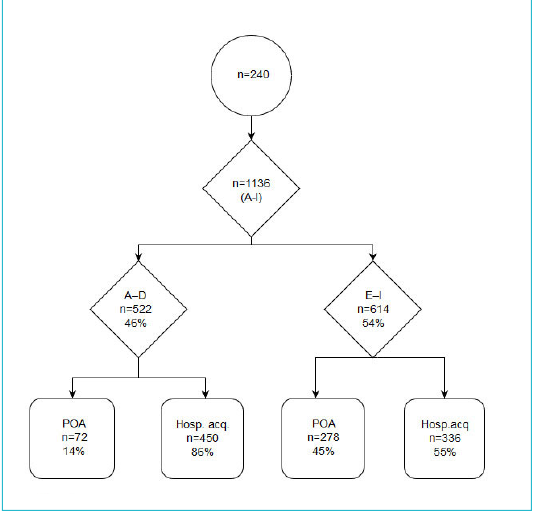
Figure 2: Overview of the severity and point of origin of the identi- fied events.Hosp. acq. = hospital-acquired; POA = present on ad- missionThe National Coordinating Council for Medication Error Re- porting and Prevention Index (NCC MERP) categories: A–D = no